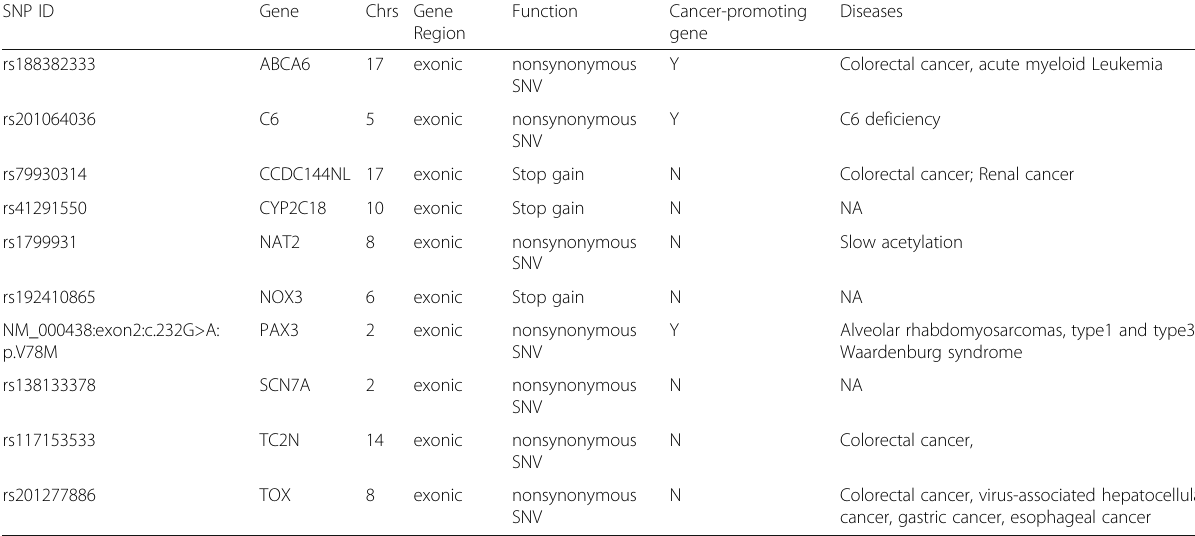
Table 1 Somatic variants may initiate tumor development SNP ID